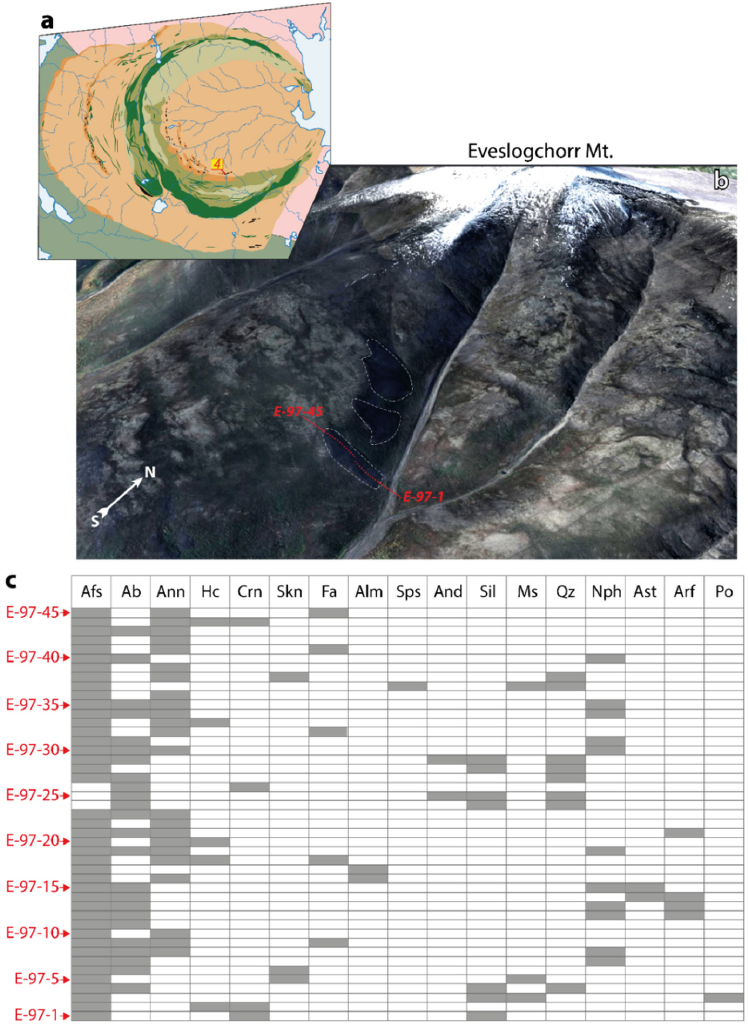
Figure 5. Outcrops of aluminous hornfelses on the southern slope of Eveslogchorr Mt. in the Khibiny massif. ( a ) location of xenoliths (sampling point 4) on the geological scheme of the Khibiny massif; ( b ) outcrops of three xenoliths (marked with a white dotted line). The sampling profile from point E-97-1 (67°39 ′ 59.6 ″ N 33°58 ′ 56.5 ″ E) to point E-97-45 (67°39 ′ 56.5 ″ N 33°58 ′ 35.4 ″ E) is shown with a red dotted line. The sampling interval is from 1.2 to 5 m; ( c ) rock-forming minerals (gray rectangles) of hornfelses sampling along the profile from point E-97-1 to point E-97-45. Only minerals whose content exceeds 10 mod. % are marked by gray rectangles.